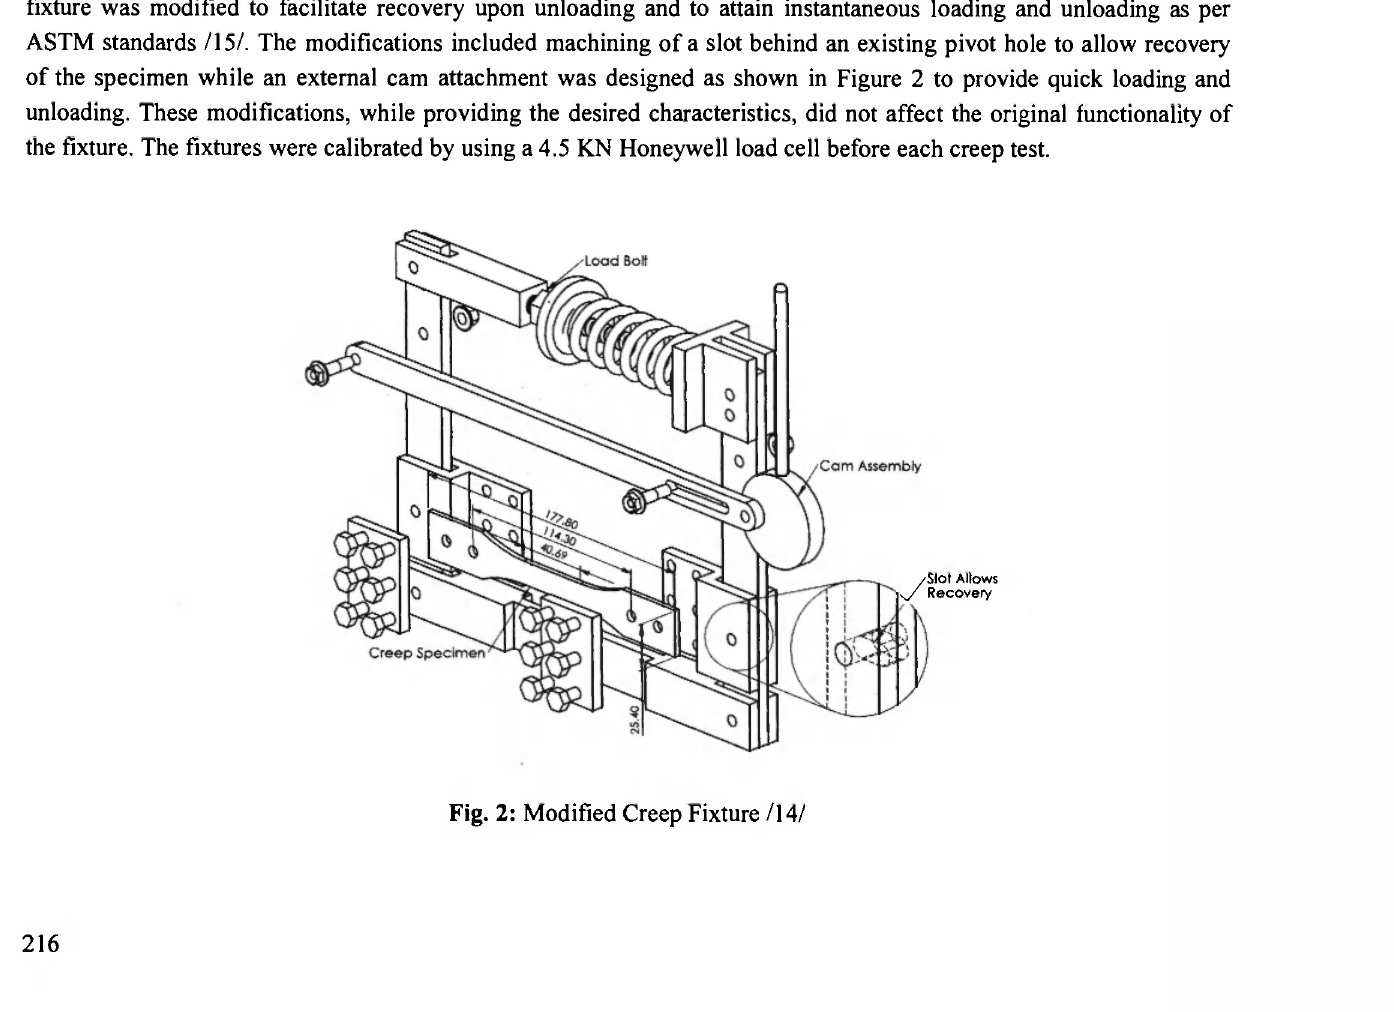
Fig. 2: Modified Creep Fixture